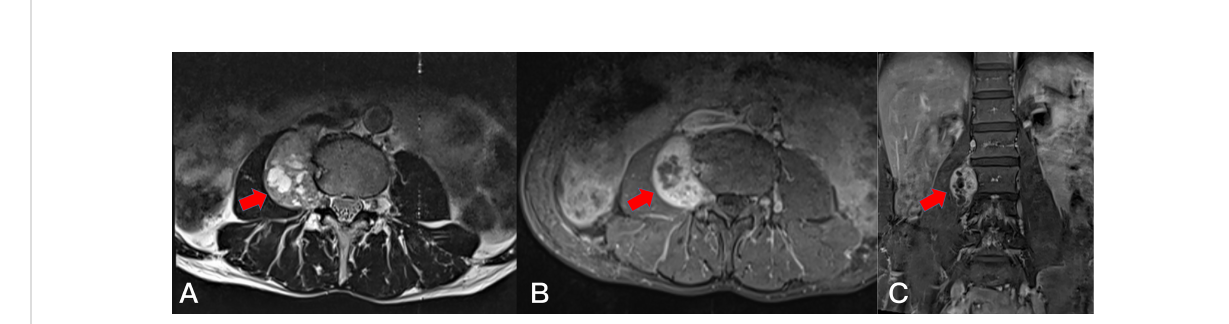
FIGURE 8 Preoperative T2-weighted MRI on axial (A) plane, T1-weighted enhanced MRI on axial (B) plane and sagittal (C) plane, revealing a dumbbell tumor (Eden IV) in the right L3-4 segment (red arrows).